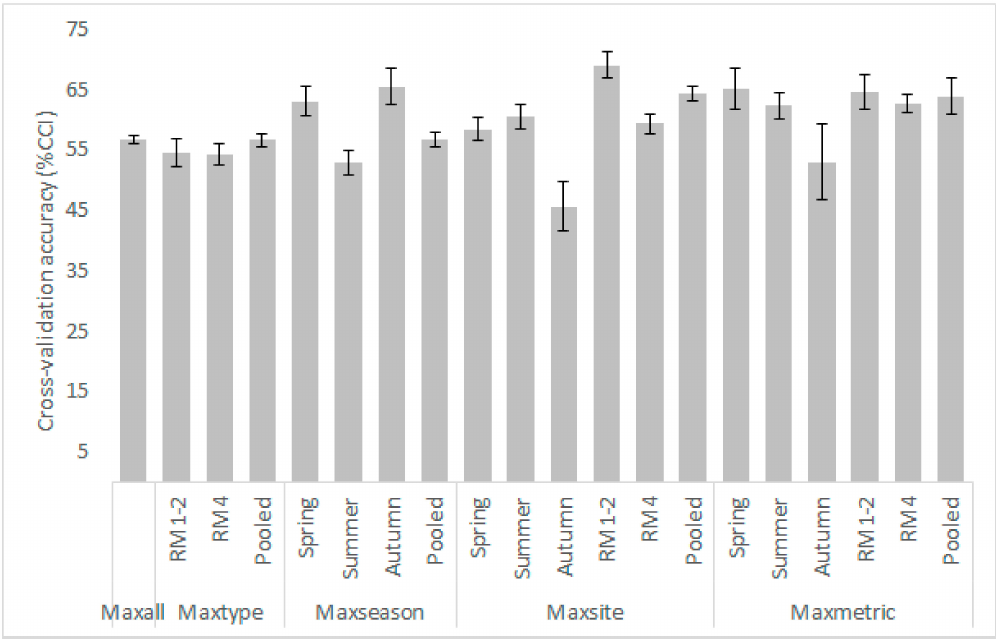
Figure A6. Mean (gray shaded columns) and standard deviation values from the 10-fold cross validation process for each κ -normalization alternative (model) applied for the Parapeiros reach. CCI: Correctly Classified